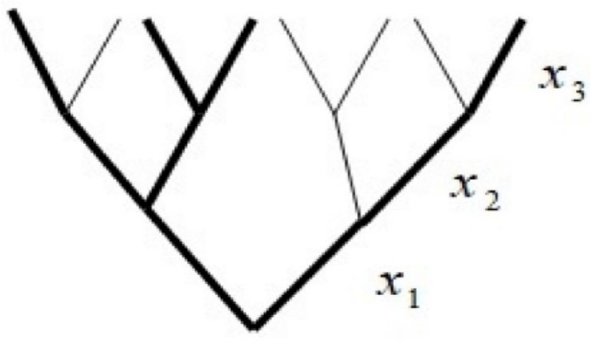
Figure 1. Boolean function of three variables encoded on a logic tree.